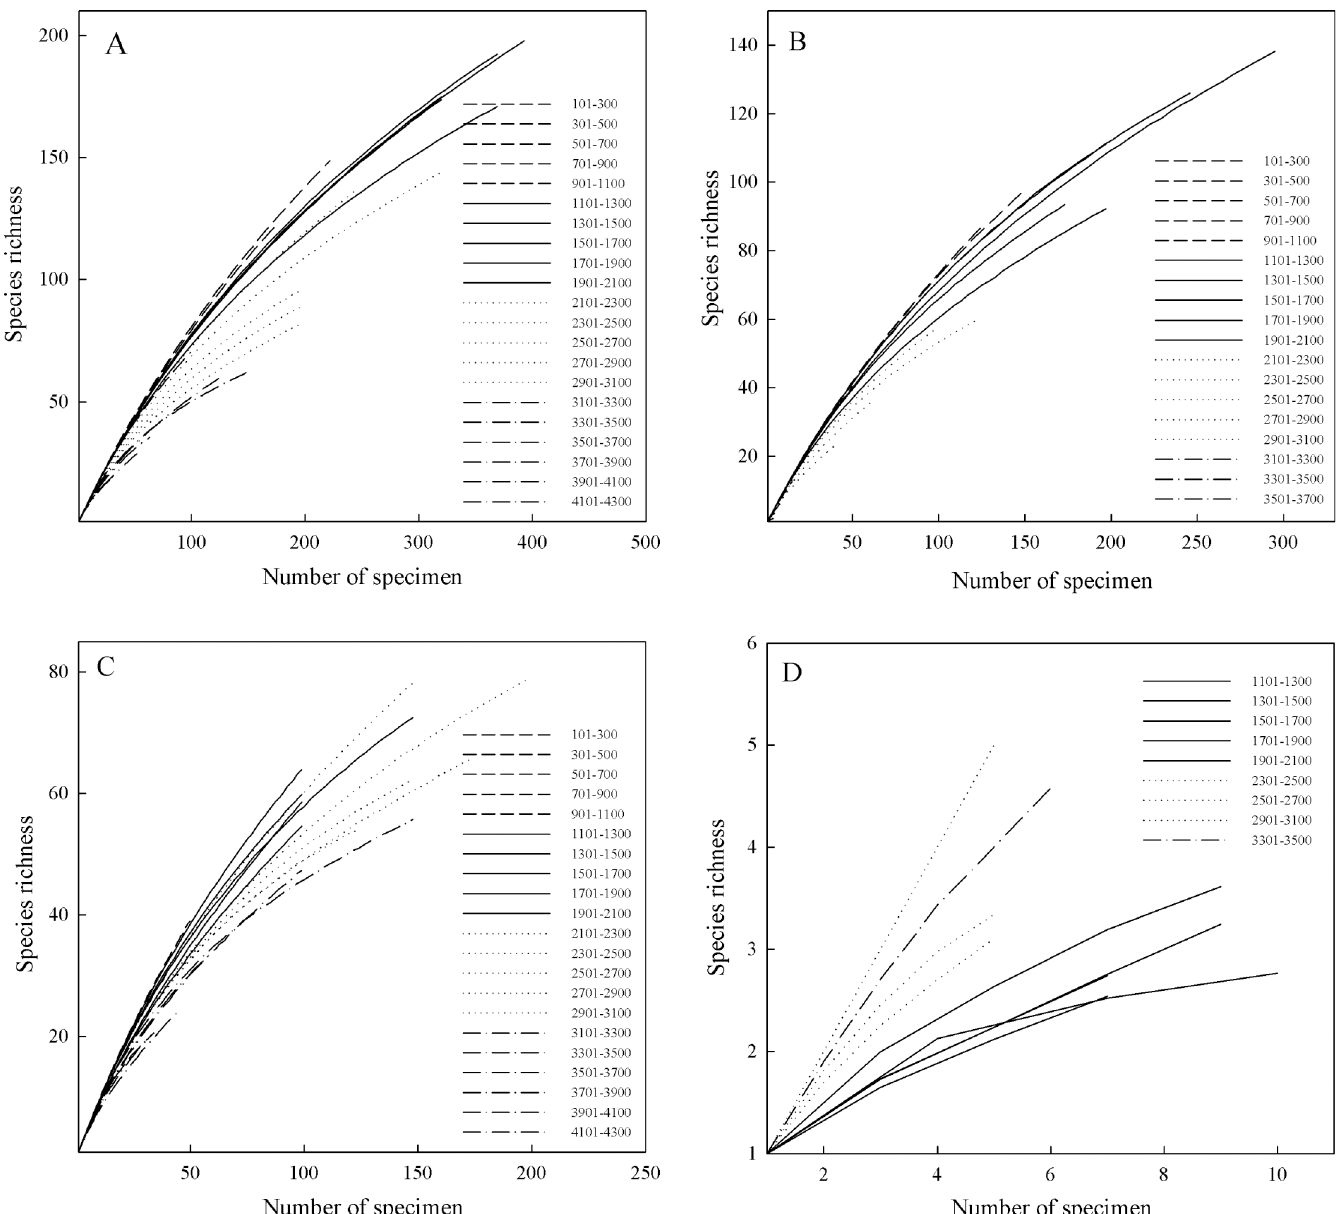
Fig 4. Rarefaction curves for all orchid species (A), and for terrestrial (B), epiphyte (C), and saprophyte (D) life forms in Yunnan, China. The legends refer to the elevational belts for different curves. The curves are the average result of randomly sampling the specimens 1000 times for each elevational